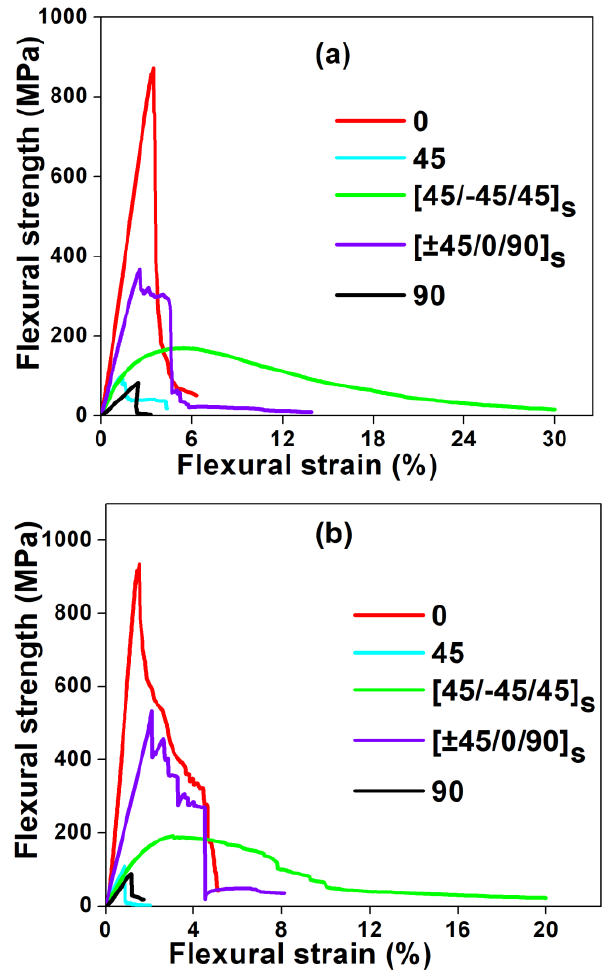
Figure 3. Flexural properties of composites: ( a ) GFRP and ( b ) CFRP.